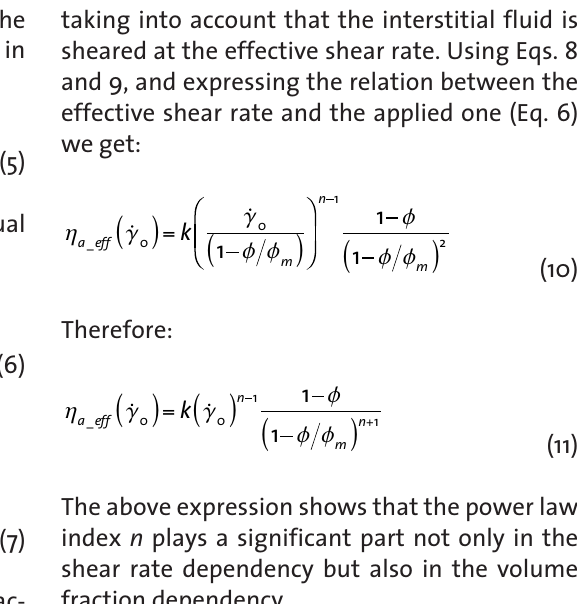
Figure 8 (left): Schematic illustration of the relation between effec- tive and real shear rate within the suspension (from Ref [21]). Figure 9: Power law behaviour of suspensions containing 500 ppm Xanthan, at different solid volume